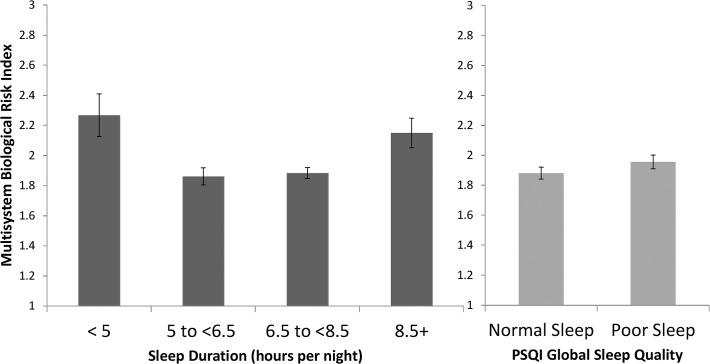
Estimated mean and standard error of multisystem biological risk by sleep duration (1a) and PSQI global sleep score (1b).Mean and standard error estimates derived from model after adjustments by age, gender, race, BMI, education, income poverty ratio, chronic conditions, and self-evaluated physical health. Multisystem Biological Risk score ranged from 0–7.